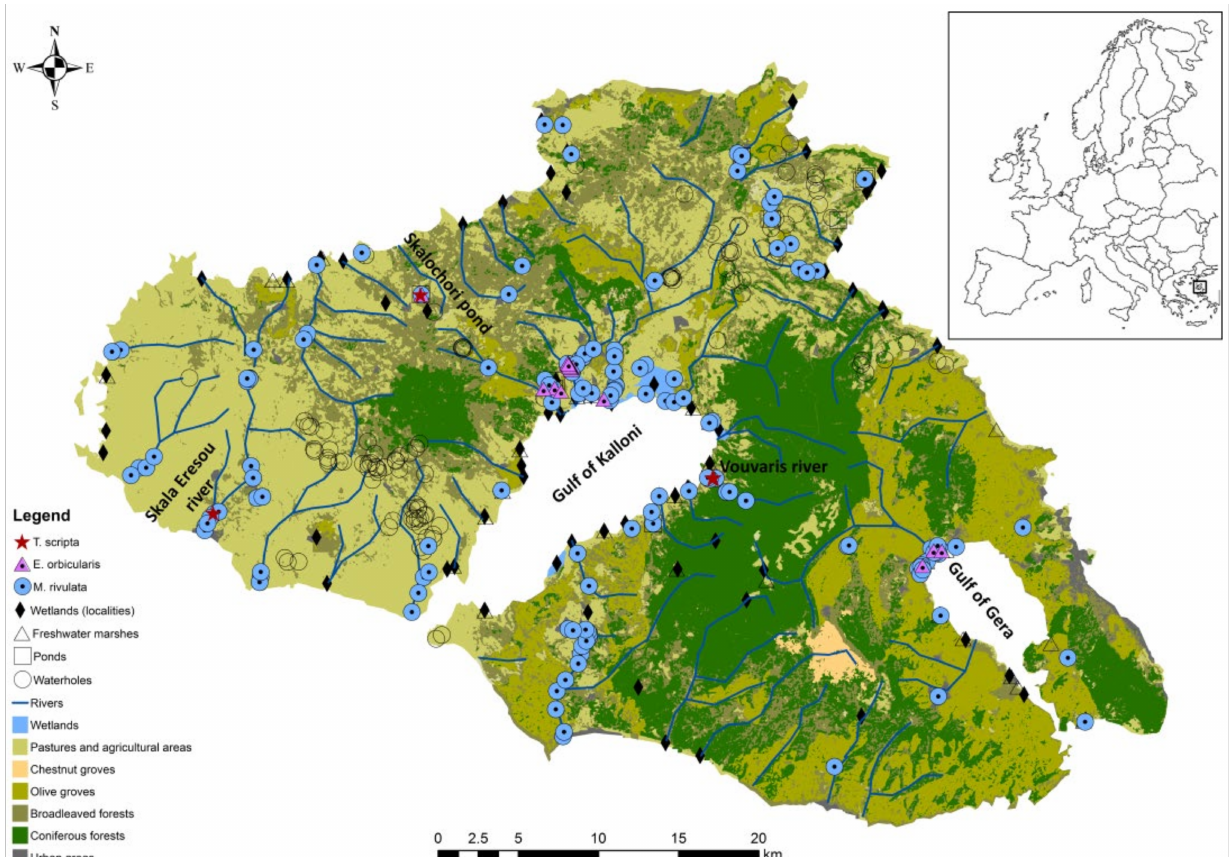
Figure 2. Main localities of occurrence of the introduced T. scripta and the native species, M. rivulata and E. orbicularis on the island of